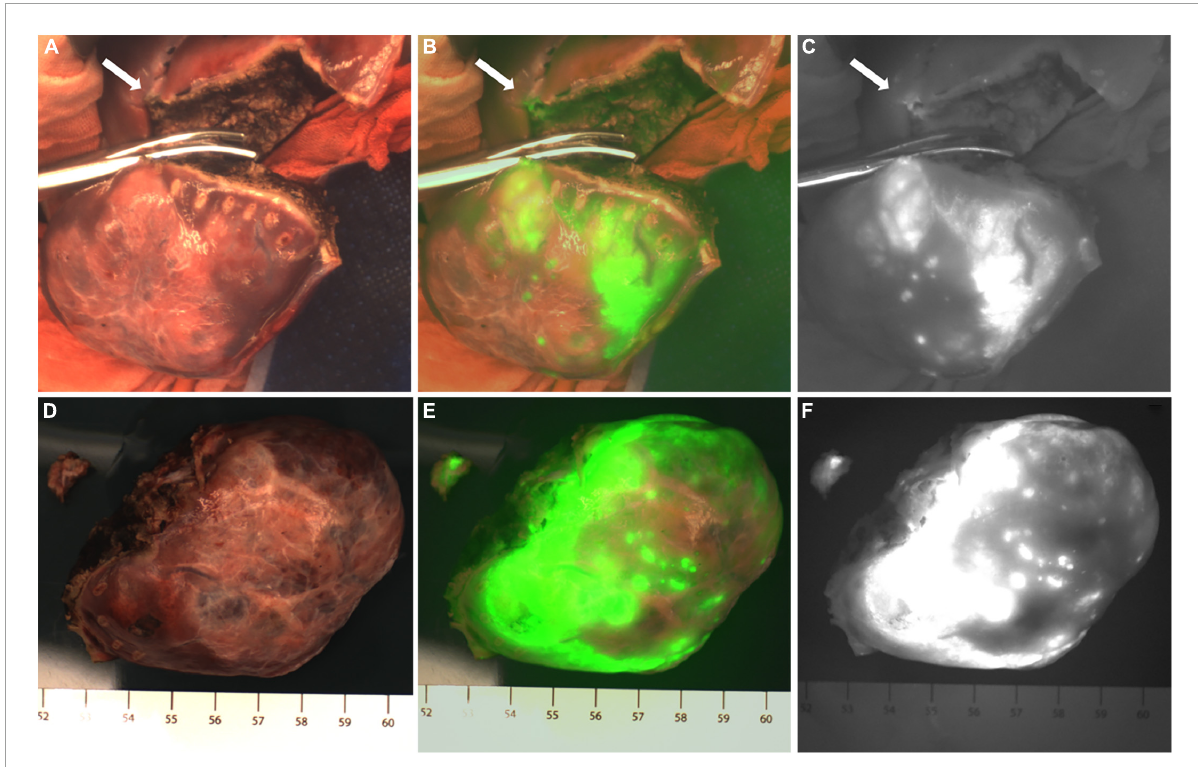
FIGURE5 Case 3. Near infrared images of tumors and ICG (+) lesion in vivo (A–C) and in vitro (D–F) , with white arrows pointing to ICG (+) lesion. The white-light image, fusion image and fluorescence image are shown in turn from left to